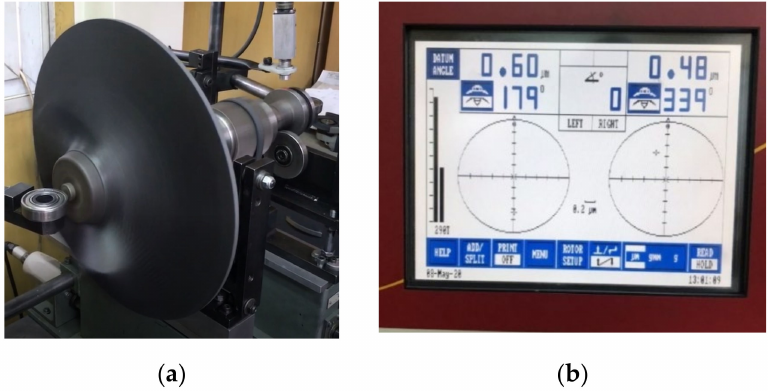
Figure 18. Representation of the ( a ) composite impeller balancing and ( b ) amplitude of unbalance identification.